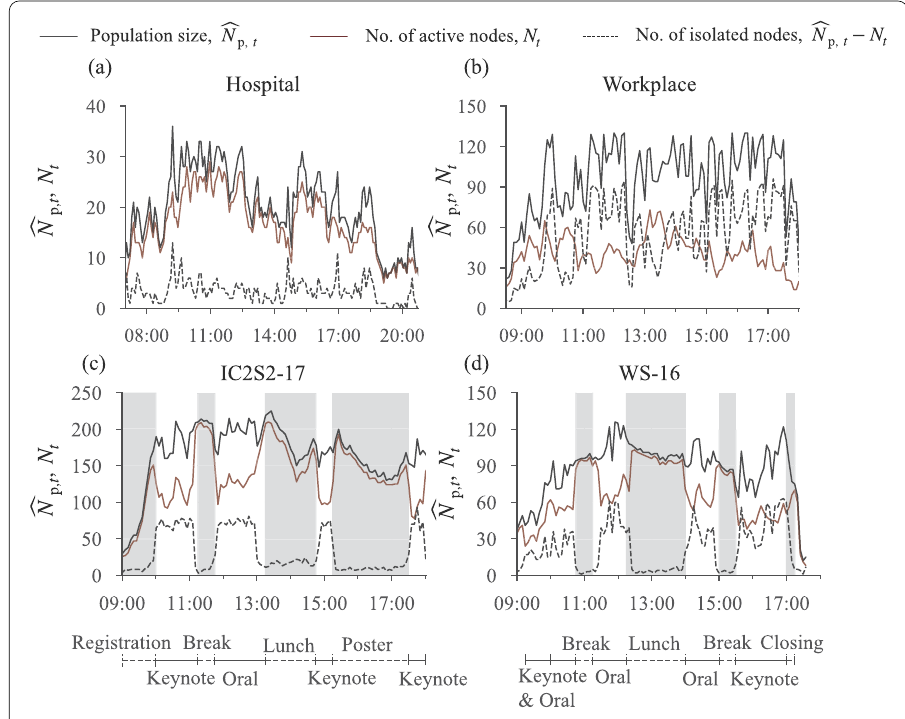
Figure 4 Estimated size of network population, (cid:6) N p , t , number of active persons, N t , and total isolated nodes, (cid:6)